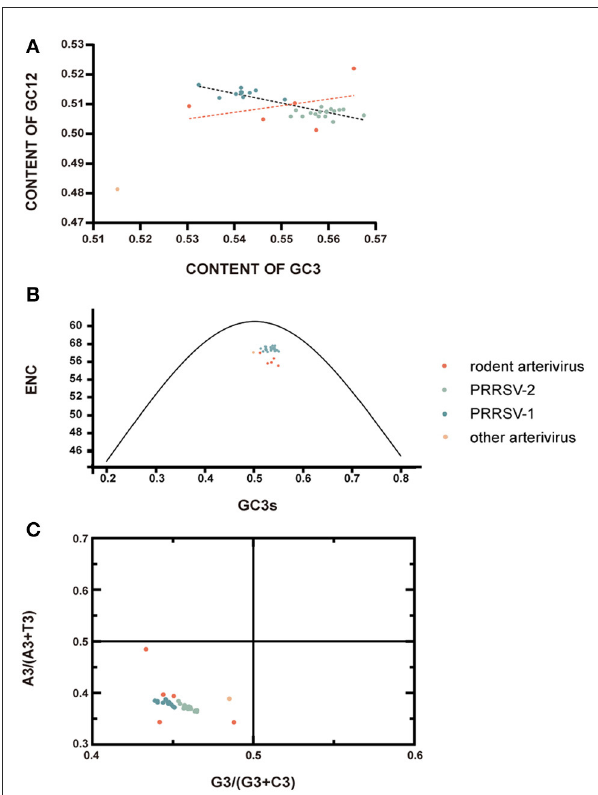
FIGURE3 Selection pressure analysis. (A) Neutrality plot analysis. GC12 plotted against GC3. The dashed black line is fitted by the scatter points of GC12 and GC3 of PRRSV, and the black formula next to it illustrates the relationships between them; rodent arterivirus is represented by the orange line. (B) ENC plotted against GC3s. The black curve represents the theoretical ENC values when the codon usage was only determined by the GC3s composition. (C) PR2-plot analysis. A3/(A3 + U3) is plotted against G3/(G3 + C3); the midpoint represents A = U and G =